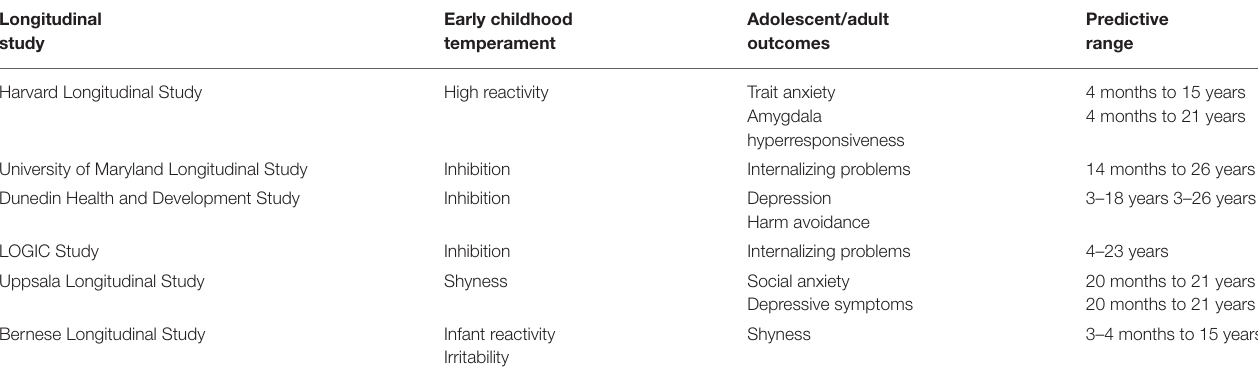
TABLE 1B | Infant-to-preschool temperamental predictors of adolescent and adult personality and psychopathology: inhibition/fearfulness. Longitudinal study